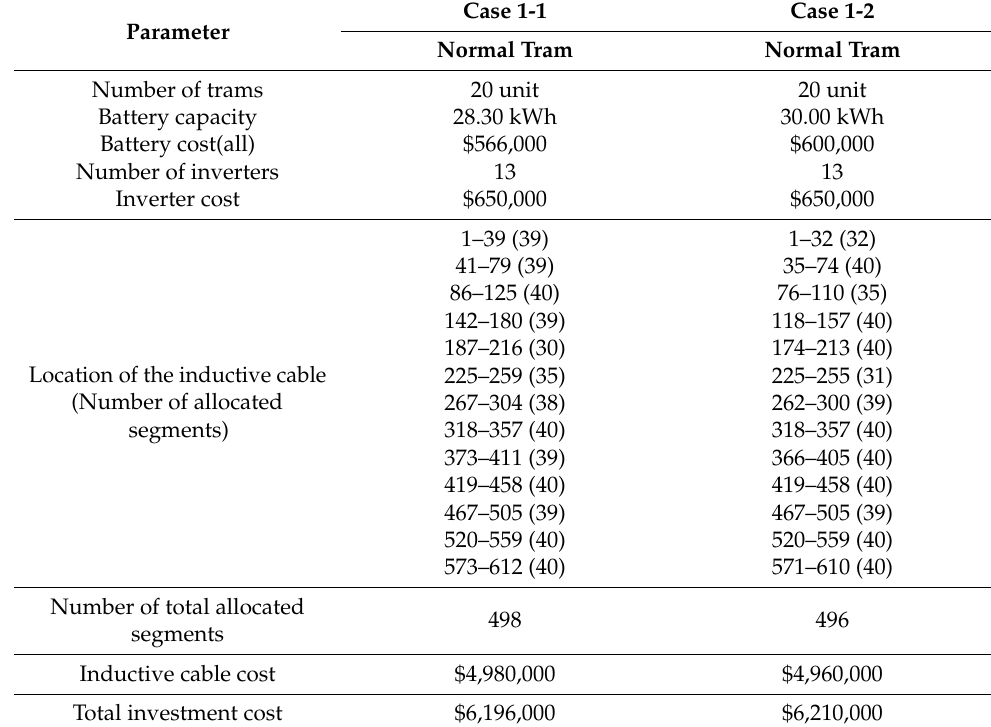
Table 4. Results of the computational experiments (Case 1).